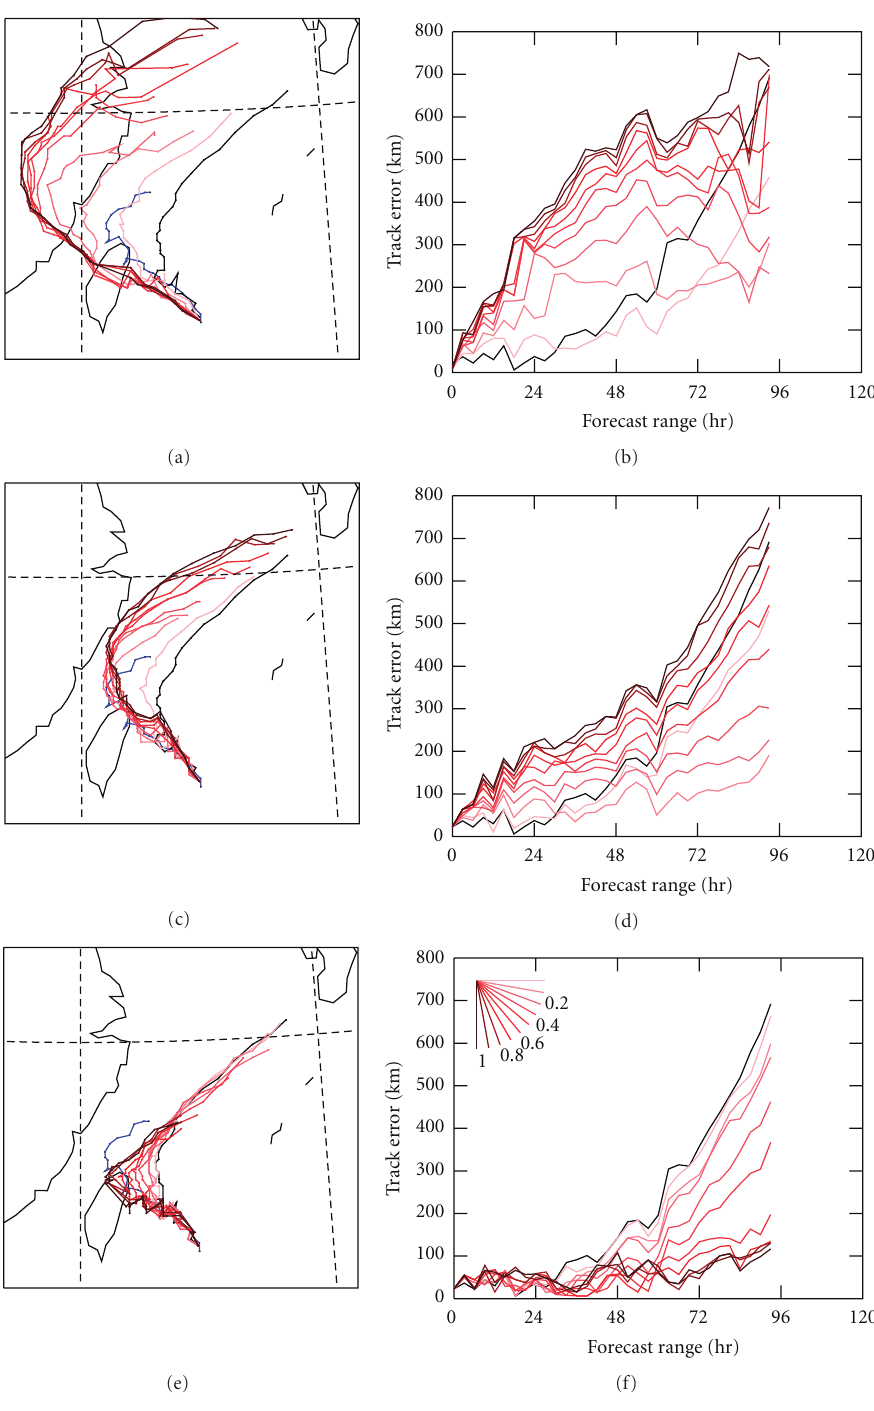
Figure 3: The predicted typhoon tracks for the runs initialized at 1800 UTC, 11 September 2008. The left column shows the tracks and the right column shows the forecast error defined by the distance between the predicted and observed (best) track. (a) and (b): the 10 cases with LEN SCALING = 1.0 and VAR SCALING = 0.1–1.0 step 0.1. The color scale for the 10 cases with increasing VAR SCALING is shown at the upper left corner of panel (f). The black curve is the control run with no AIRS data and the blue curve is the observed best track. (c) and (d): similar to (a) and (b) but for the 10 runs with LEN SCALING = 0.5 and VAR SCALING = 0.1–1.0 step 0.1. (e) and (f): same as (a) and (b) but for the 10 runs with LEN SCALING = 0.1 and VAR SCALING = 0.1–1.0 step